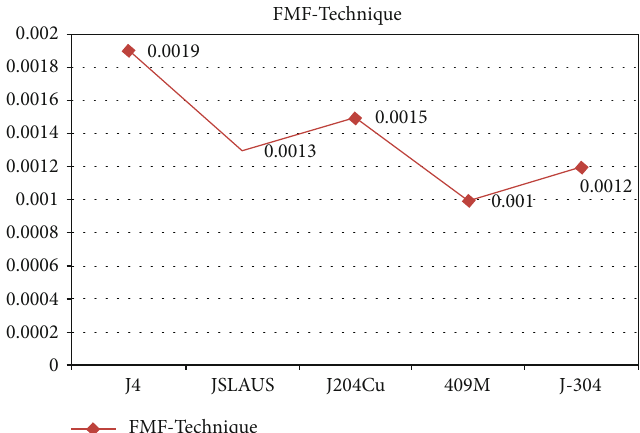
Figure 2: Crisp-FMF application for evaluating EAI of TEHES tube material under TEHES-O-S-tube material evaluation